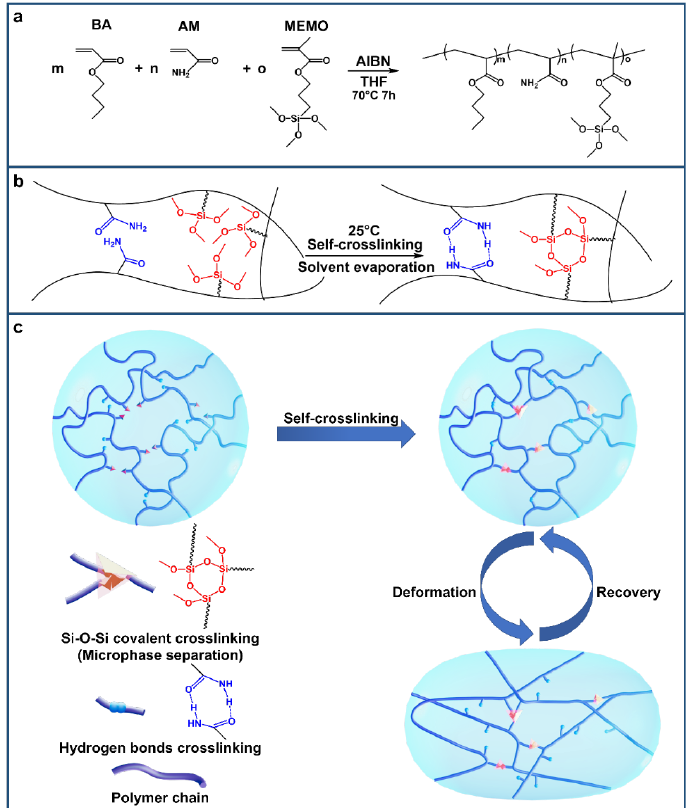
Figure 1. Design concept and synthesis. ( a ) Synthesis of the SCDCE: copolymerize BA, AM, and MEMO by one-pot free-radical copolymerization with AIBN initiator. ( b ) Self-crosslink. ( c ) Schematic description of self-crosslinking mechanisms and proposed mechanisms for the energy dissipation of SCDCs under deformation.